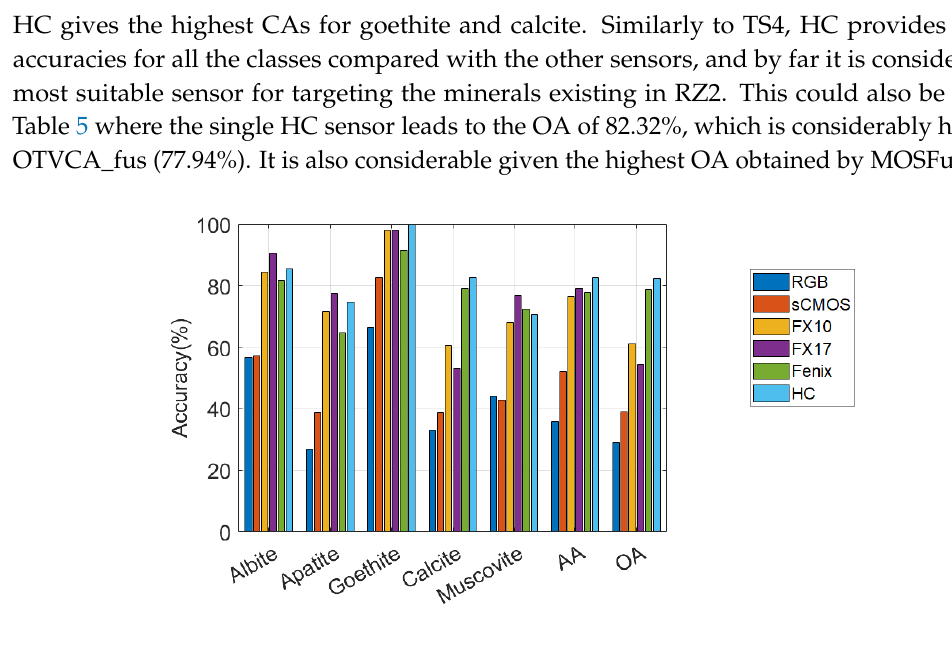
Figure 7. The performances of different optical sensors on different minerals in terms of accuracy in percentages obtained by applying SVM on the spectral bands of the RZ2